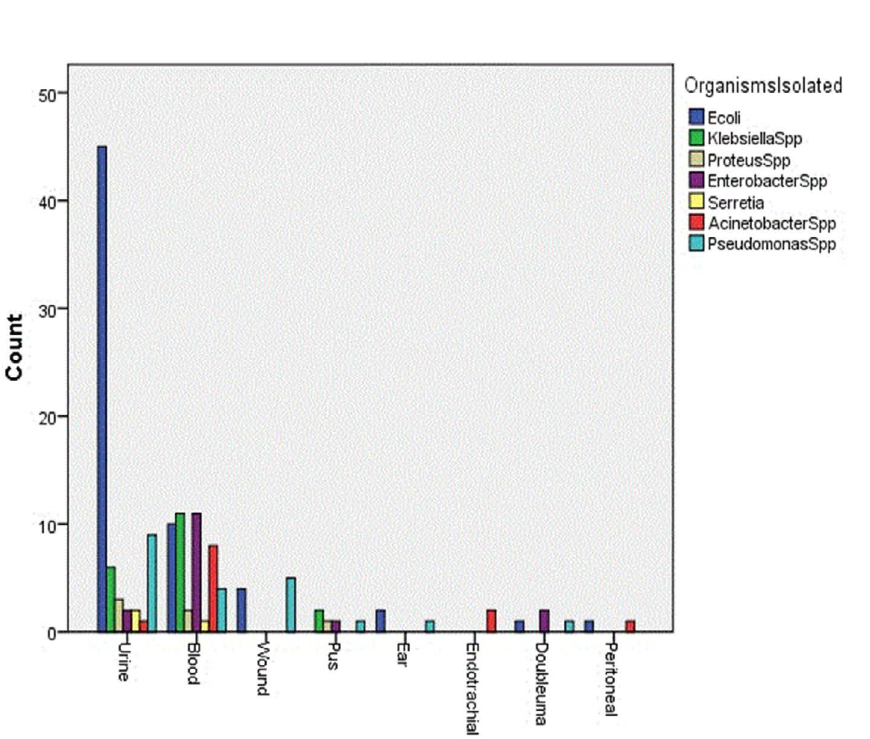
Fig. 1. Distribution of Organisms Isolated from various Clinical sample